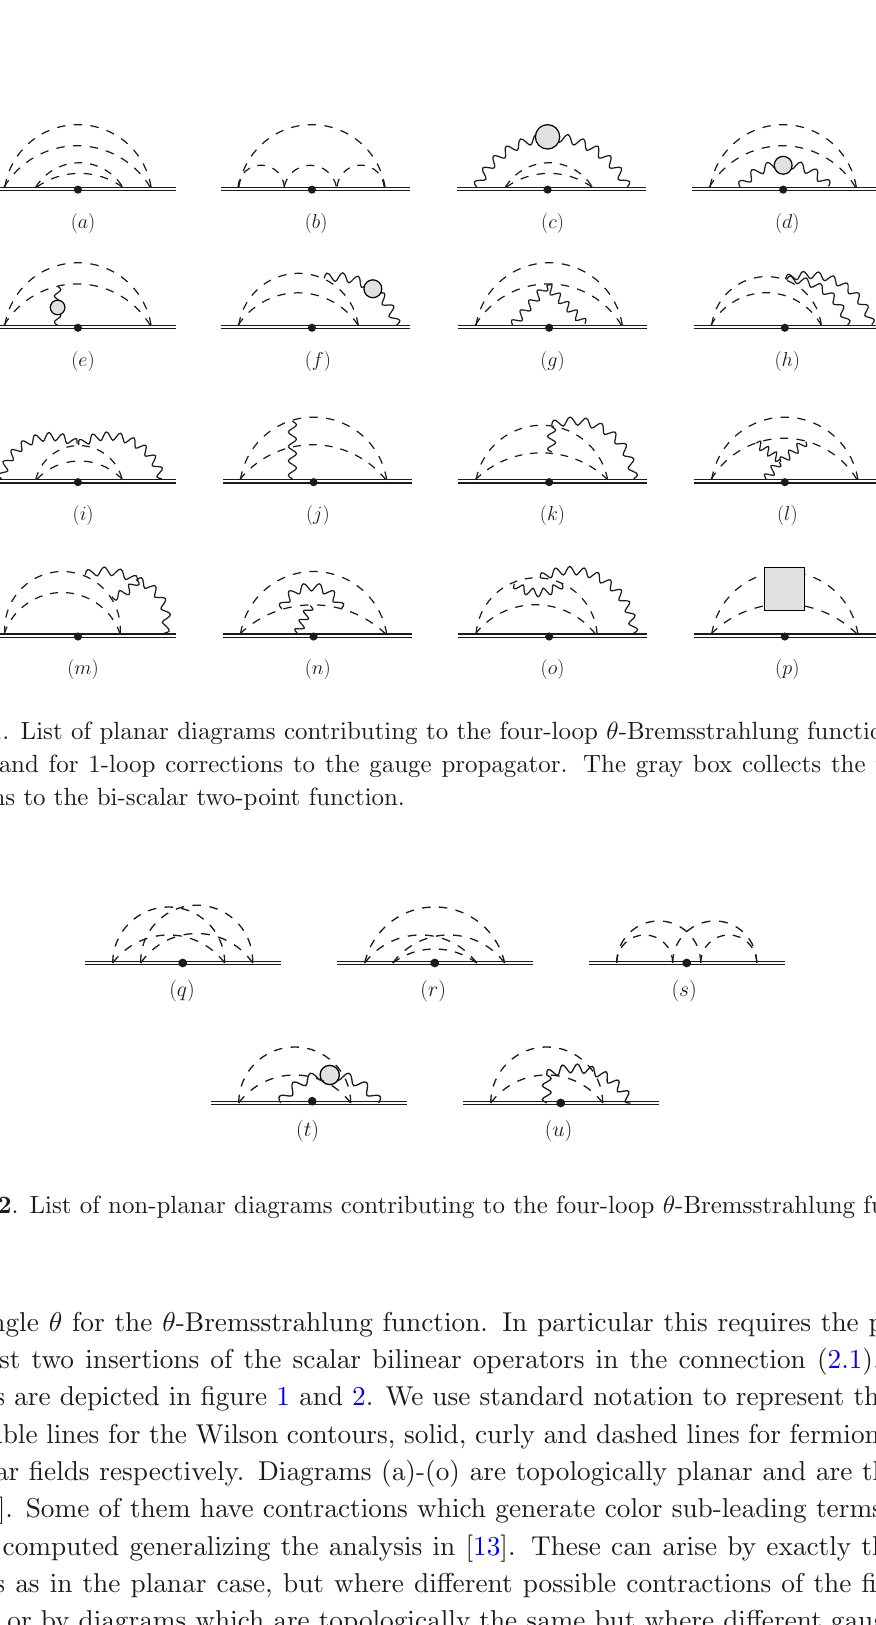
of the angle θ for the θ -Bremsstrahlung function. In particular this requires the presence of at least two insertions of the scalar bilinear operators in the connection ( 2.1).